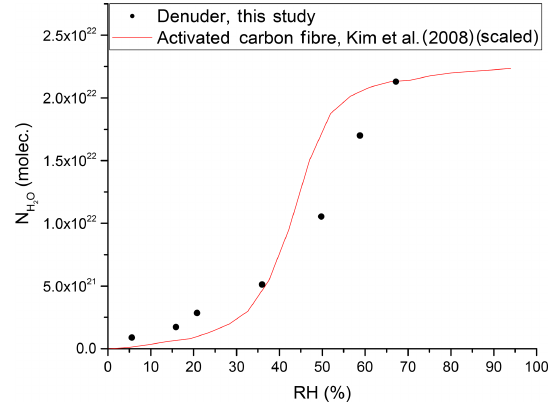
Figure 9. Number of adsorbed water molecules onto the denuder surface at equilibrium versus RH. The red line represents (scaled) results from a study on activated carbon fibre (Kim et al.,